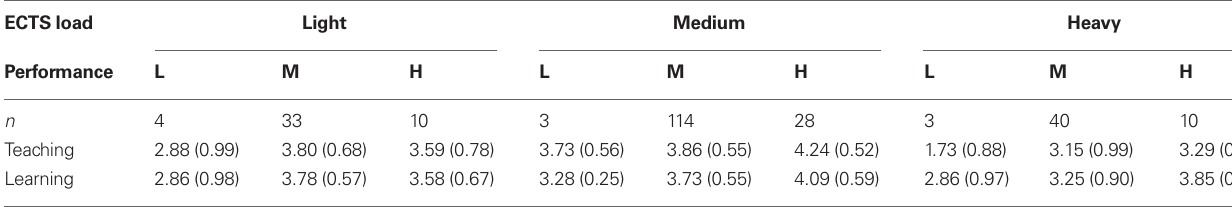
Table 4 | Mean values for the TLP according to ECTS credit load and performance